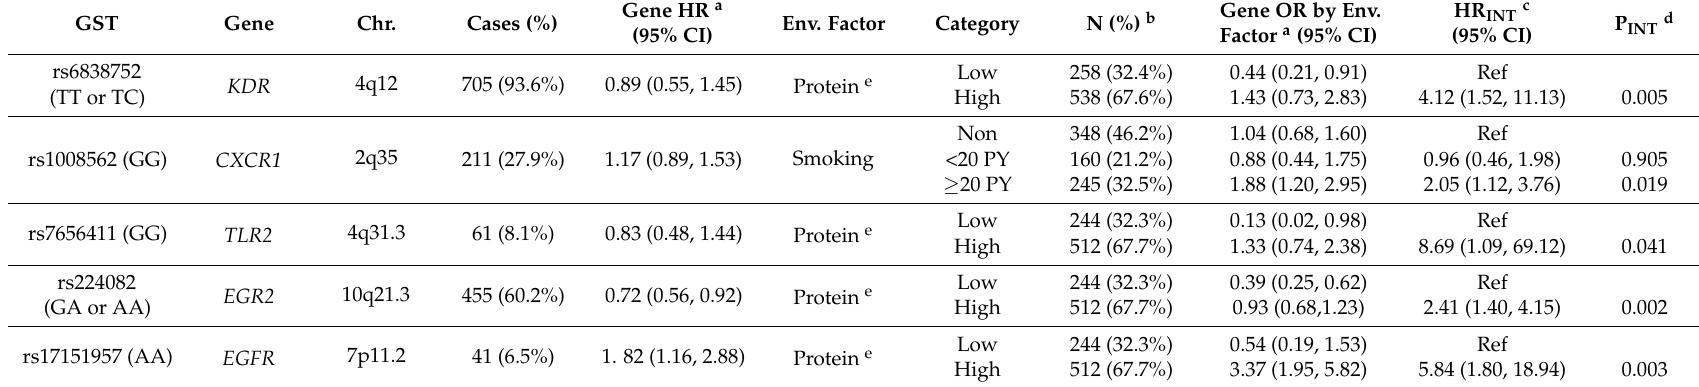
Abbreviations: GST, Gene-Specific Tree; Chr., Chromosome; Env., Environmental; PY, pack-years; HR, hazard ratio; CI, confidence interval. a Gene hazard ratios were adjusted for age, sex, race, study center, pathway tree, baseline hazard stratified by cancer stage; b N (%) frequency of the environmental variable within subjects with the GST; c HR INT : Interaction hazards ratio; d P INT : Interaction p -value; e Animal/Vegetable Protein